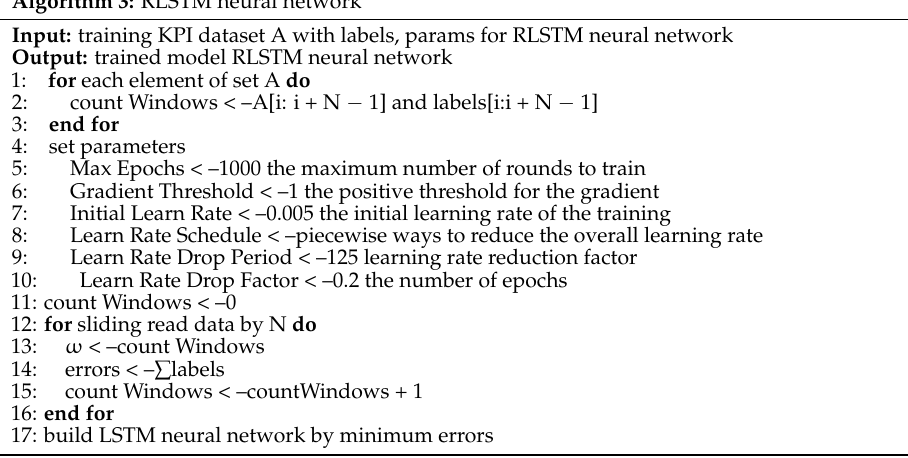
Algorithm 3: RLSTM neural